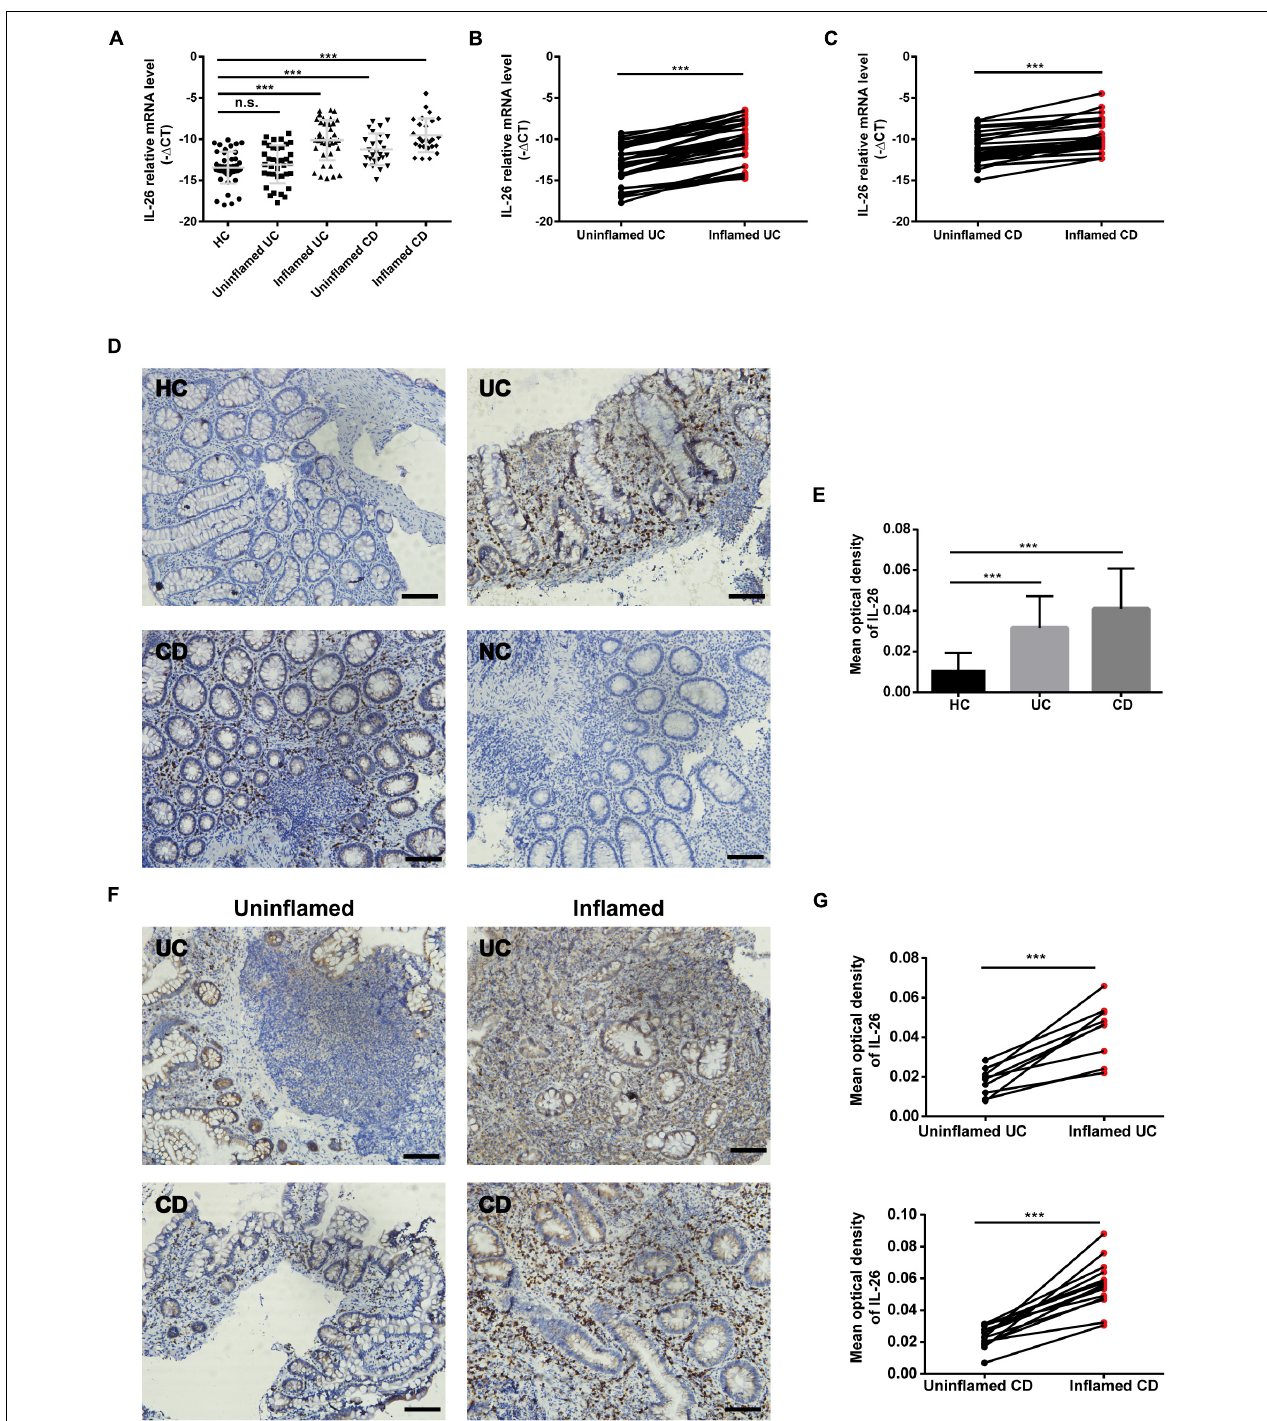
FIGURE 1 | IL-26 expression is increased in the inflamed intestinal mucosa of IBD patients. (A) IL-26 mRNA levels in inflamed and uninflamed intestinal mucosa from UC patients ( n = 37) and CD patients ( n = 26), and normal intestinal mucosa from healthy controls (HC) ( n = 45). (B,C) IL-26 mRNA levels in paired inflamed and uninflamed intestinal mucosa from patients with UC ( n = 37) (B) and patients with CD ( n = 26) (C) . (D) Immunohistochemical staining for IL-26 in intestinal mucosa from patients with UC and CD, and HC. Negative control (NC): omission of the primary antibody. Scale bar, 100 µ m. (E) The semi-quantitative analysis of immunohistochemistry staining of IL-26 in intestinal mucosa from patients with UC ( n = 22) and CD ( n = 28), and HC ( n = 23). (F) Immunohistochemical staining for IL-26 in paired inflamed and uninflamed intestinal mucosa from the same UC and CD patients. Scale bar, 100 µ m. (G) The semi-quantitative analysis of immunohistochemistry staining of IL-26 in paired inflamed and uninflamed intestinal mucosa from the same UC and CD patients. *** P < 0.001. n.s., not significant.